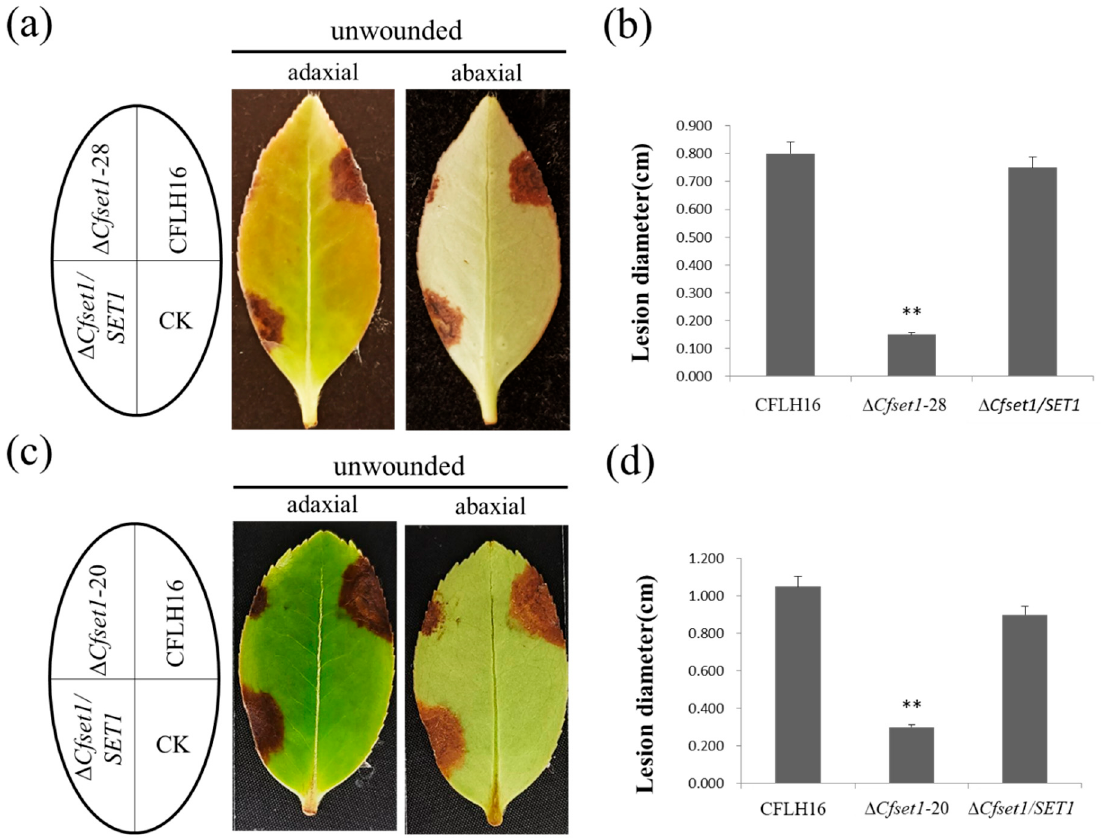
Figure 2. Pathogenicity of CfSET1 gene-deleted mutants to tea-oil leaves. ( a , c ) The pathogenicity of Δ Cfset1- 20 and Δ Cfset1- 28 was significantly weaker than both CFLH16 and Δ Cfset1 / SET1 . The tested strains caused yellow-brown, irregular -shaped lesions on tea-oil leaves. CK: blank control. ( b , d ) Statistical analysis among three strains for their lesion sizes on unwounded leaves. Double asterisks indicate each mutant has significant differences with wild-type and complemented strains ( p < 0.01).